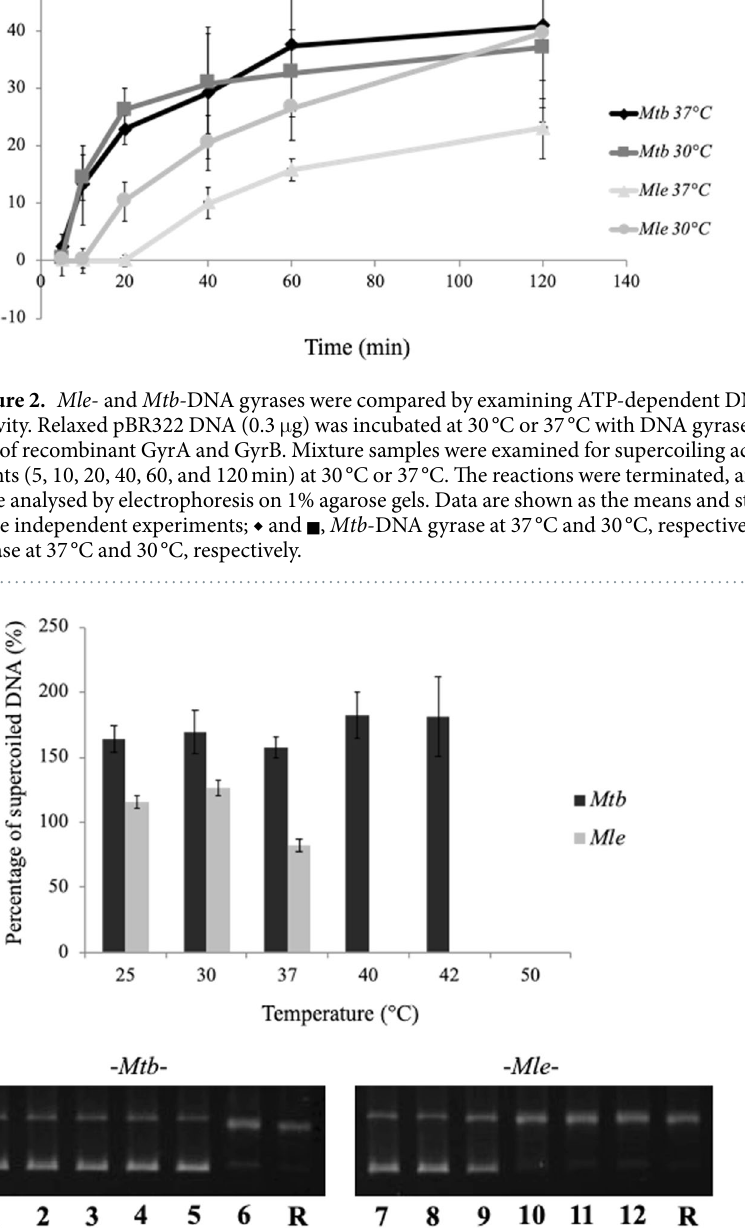
Figure 3. Thermal inactivation of Mle - and Mtb -DNA gyrases. DNA gyrases were inactivated for 1 h at various temperatures (25 °C, 30 °C, 37 °C, 40 °C, 42 °C, and 50 °C), cooled on ice for 1 h, and assayed for 1 h at 30 °C ( Mle ) or 37 °C ( Mtb ). Lanes 1 and 7, inactivation at 25 °C; lanes 2 and 8, inactivation at 30 °C; lanes 3 and 9, inactivation at 37 °C; lanes 4 and 10, inactivation at 40 °C; lanes 5 and 11, inactivation at 42 °C; lanes 6 and 12, inactivation at 50 °C. Black and gray bars indicate Mtb- and Mle- DNA gyrases. R denotes the relaxed pBR322 DNA, used as a positive